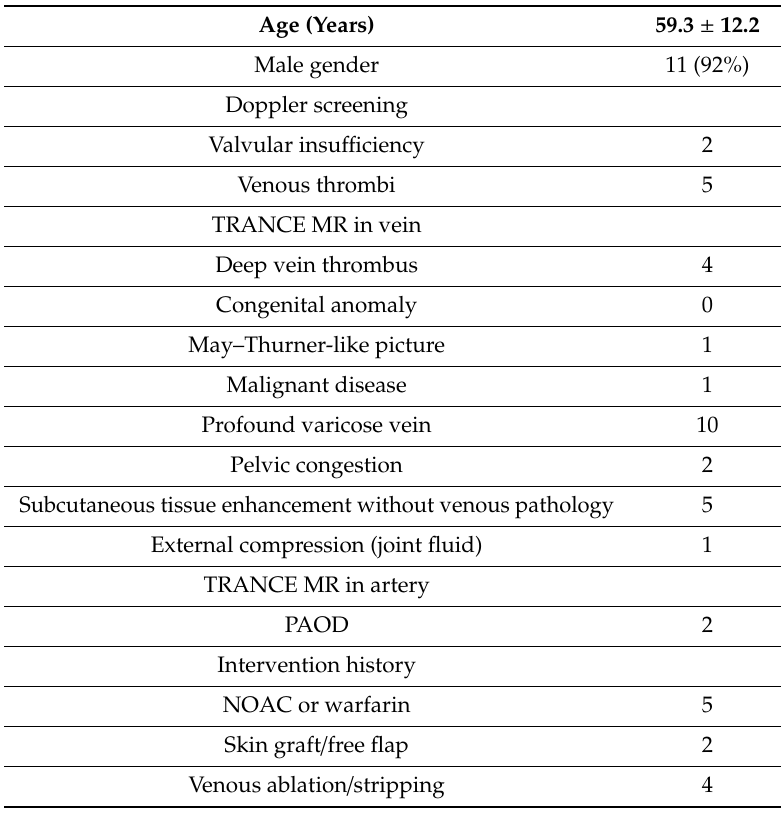
Table 3. Demographic characteristics of 12 patients with leg static ulcers.